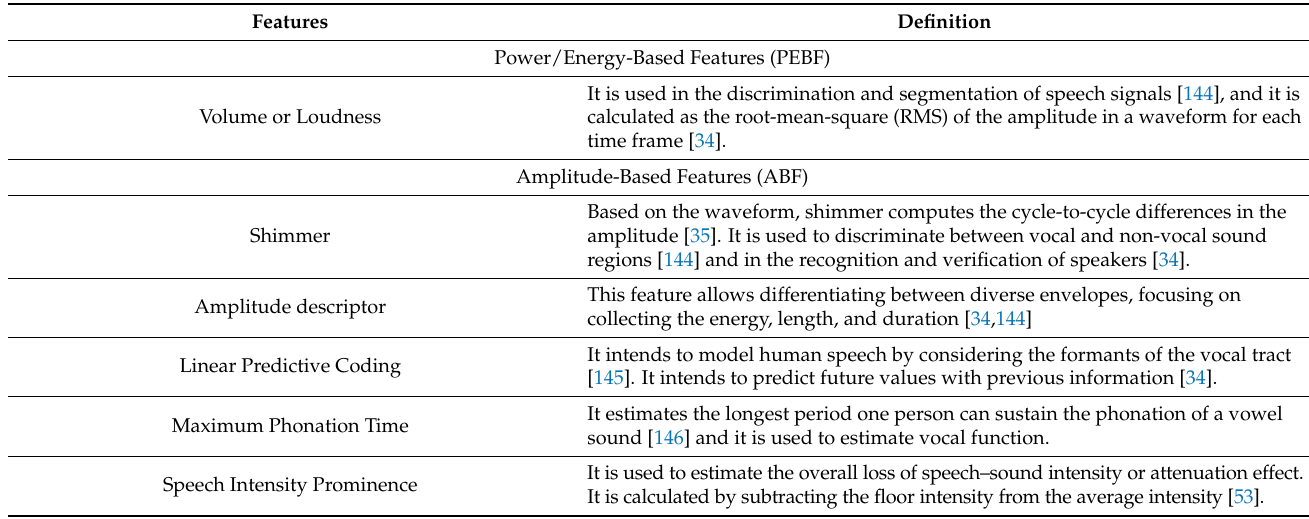
Table A1. Definitions of different time features mentioned in the studies.